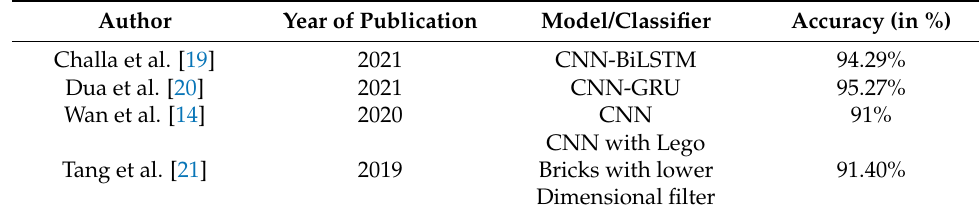
Table 2. Performance measurement of the latest HAR approaches on the PAMAP2 dataset.